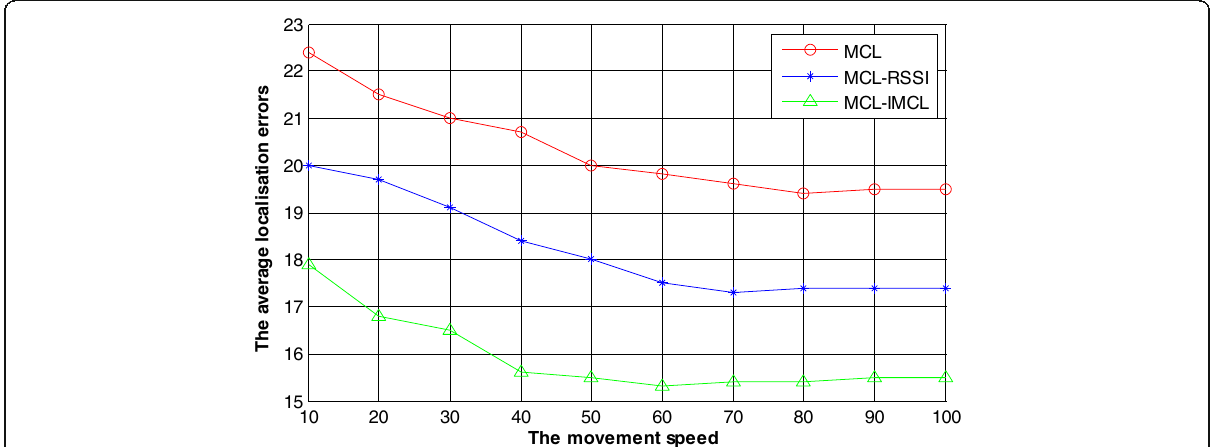
Fig. 5 Comparison of the average localization errors and the movement speed